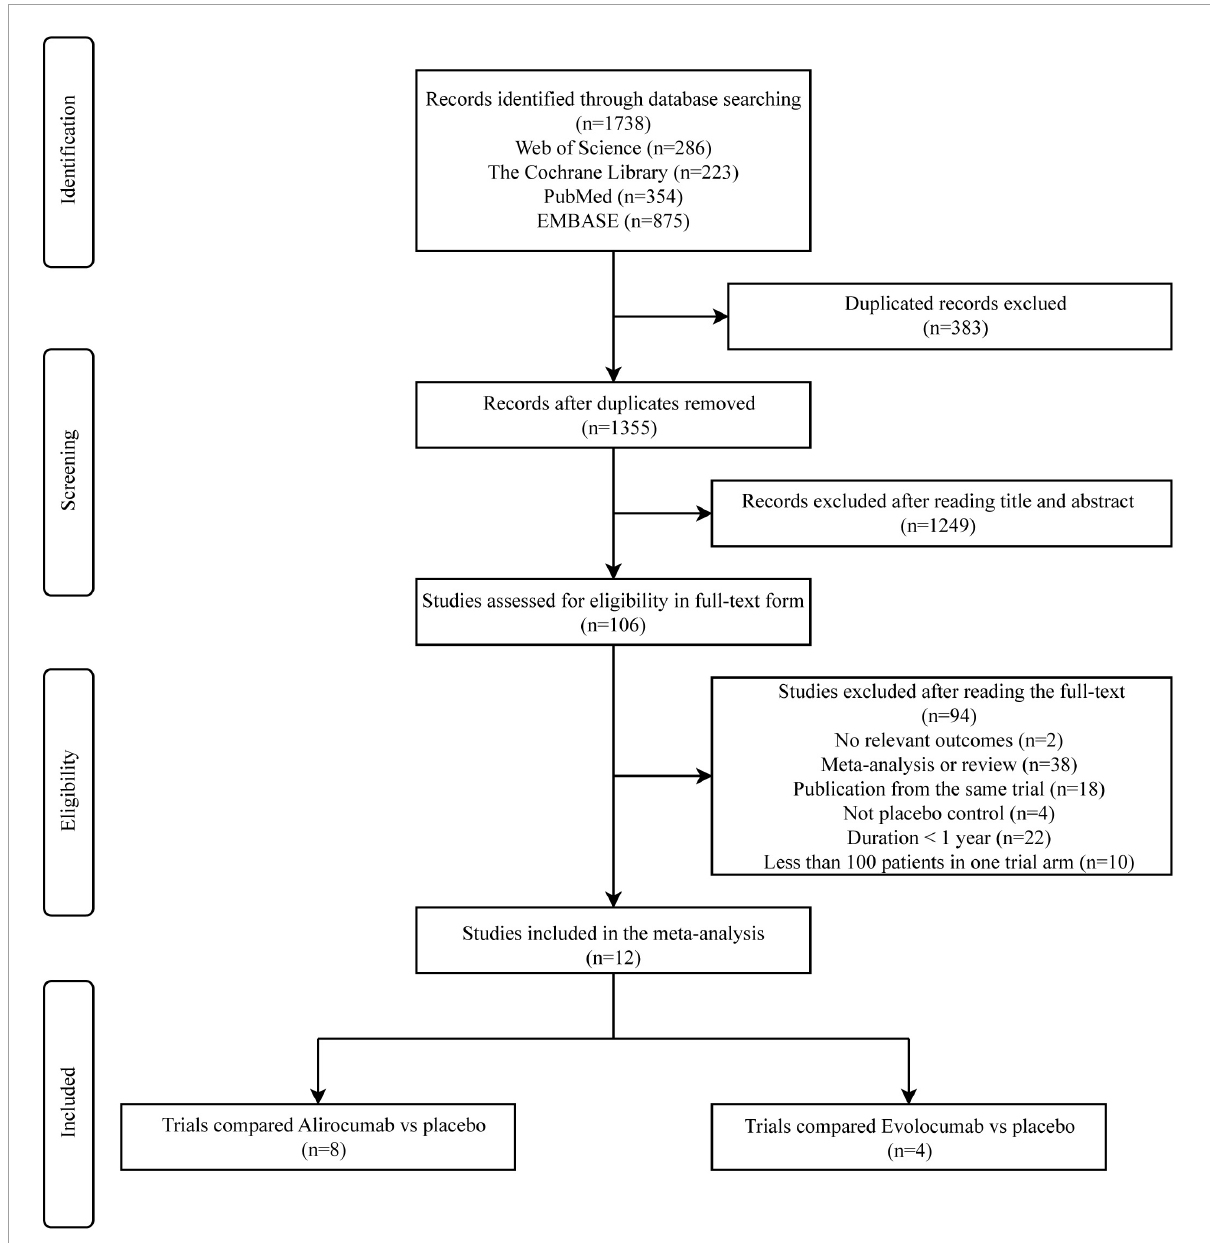
FIGURE1 Flowchart of study selection for